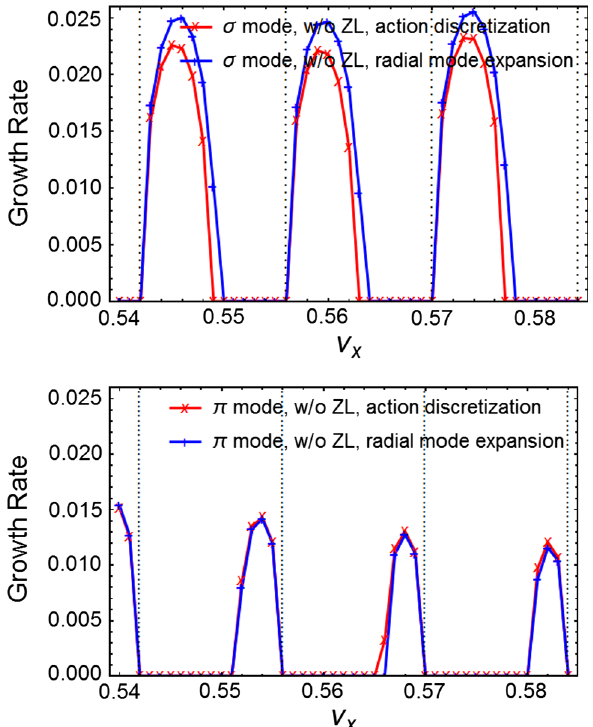
FIG. 7. Growth rate vs horizontal tune without longitudinal impedance (ZL). The upper and lower plots show the results of σ mode and π mode, respectively. The vertical lines are synchro- ¼ 0 . 5 þ n ν ¼ 0 . 014 . betatron sidebands ν , ν x s s